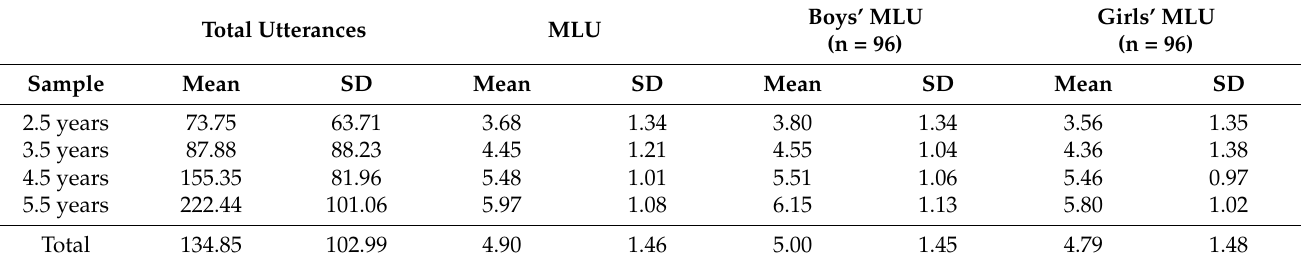
Table 1. Means and standard deviations for total utterances and MLU.